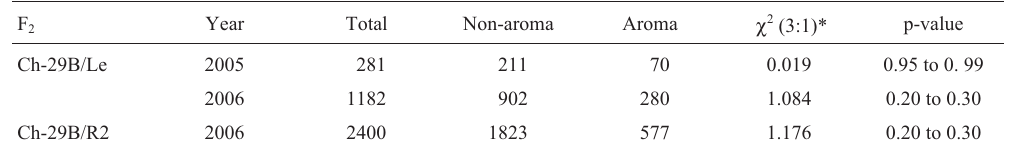
Table 1 - The segregation of aroma in F 2 populations of a cross between the aromatic rice cultivar Oryza sativa indica variety Chuanxiang-29B (Ch-29B) and the non-aromatic O. sativa japonica variety Lemont (Le) and the non-aromatic O. sativa indica variety R2.